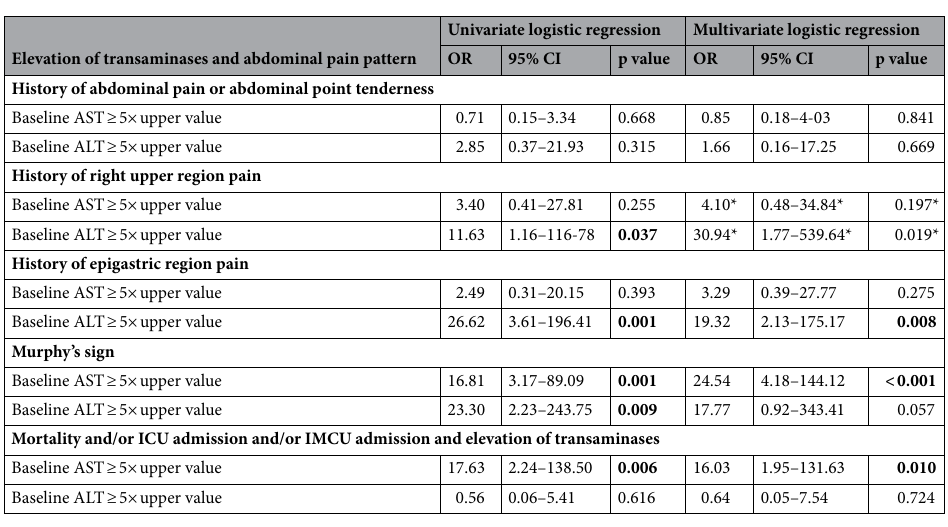
Table 4. Association between elevation of transaminases and abdominal pain pattern in SARS-CoV2 patients, before and after adjustment for sex, age, abdominal surgery during hospital stay (complete case analysis) and association between mortality and/or ICU admission and/or IMCU admission and elevation of transaminases before and after adjustment for sex, age, (complete case analyses). Patterns of abdominal point tenderness did not reach the level of significance and are not shown. OR: odds ratio, CI: confidence interval. Significant values are given in bold. *Model not valid.